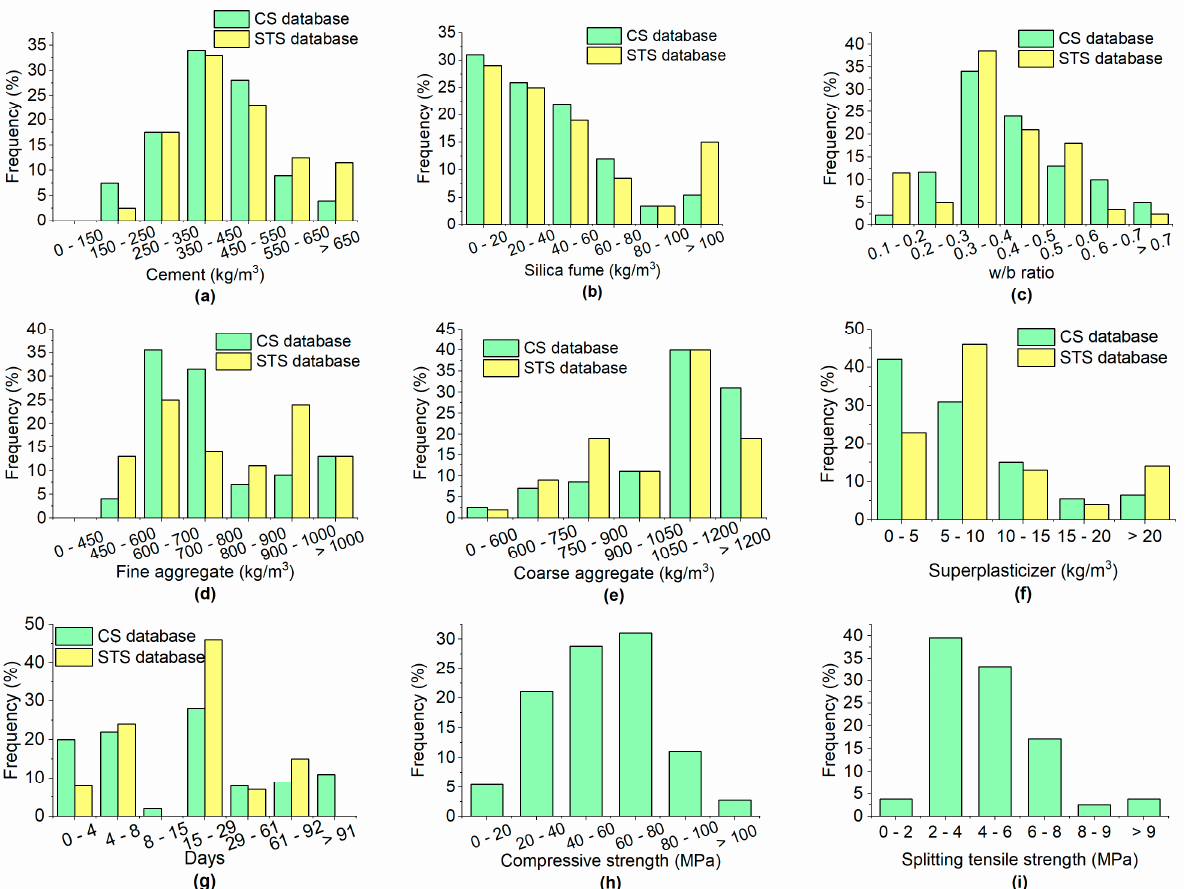
Figure 2. Histograms of ( a ) cement; ( b ) SF; ( c ) w/b ratio; ( d ) FA; ( e ) CA; ( f ) SP; ( g ) days; ( h ) CS; ( i )